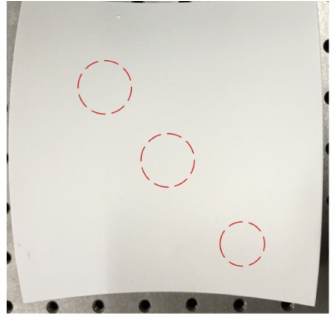
Figure 13. Three defects in the object with a hyperbolic paraboloid